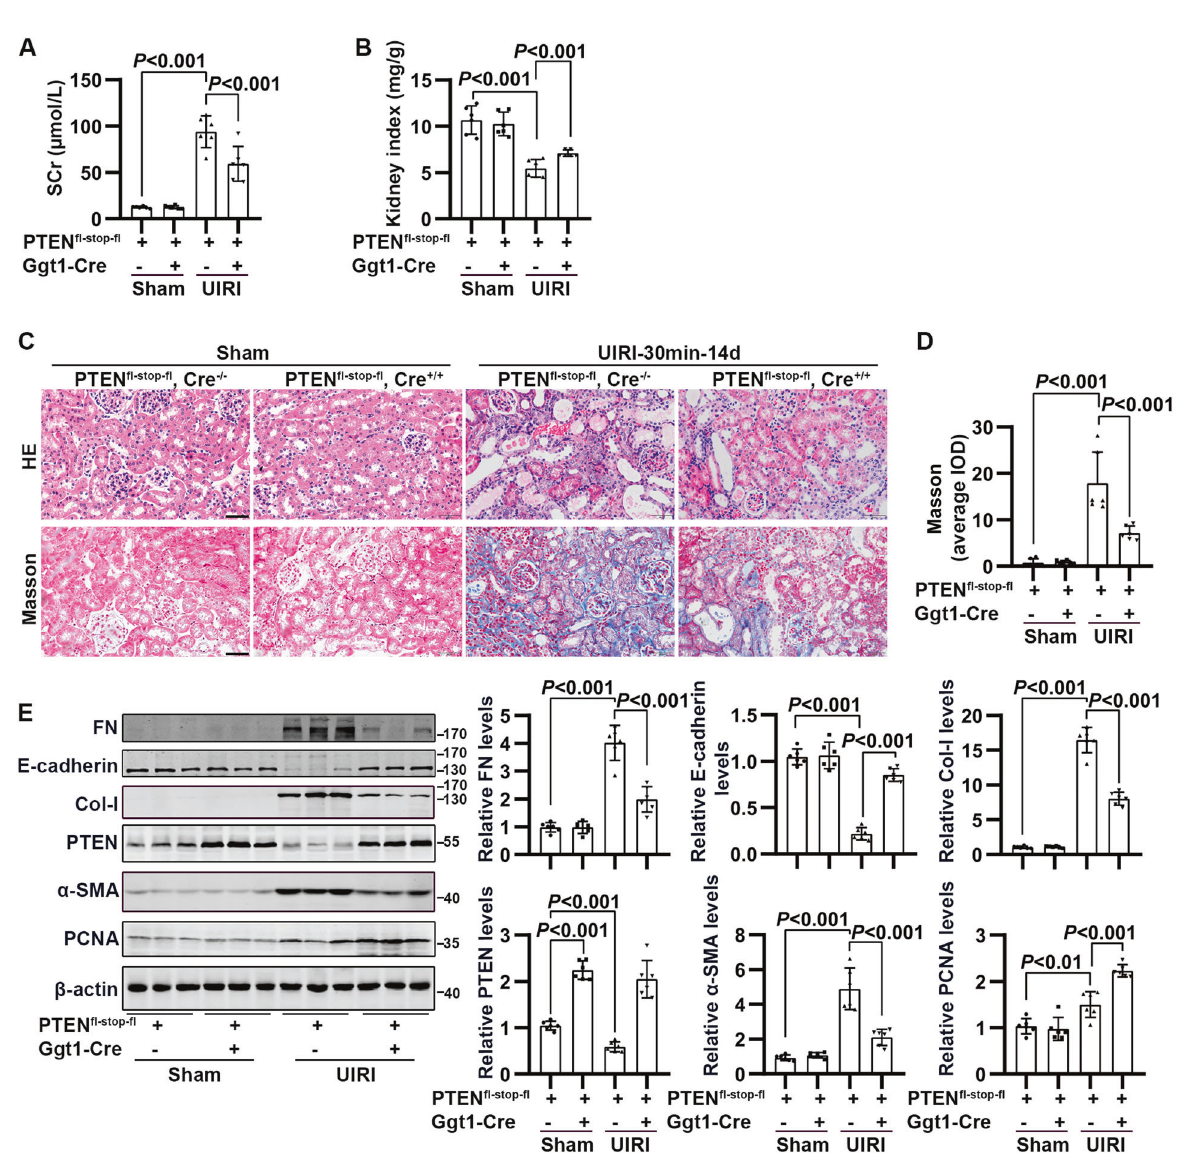
Fig. 3 The effect of renal proximal tubular cell (RPTC)-speci fi c PTEN overexpression on I/R-induced renal regeneration and fi brosis. A Concentration of serum creatinine in PTEN fl -stop- fl , Cre − / − and PTEN fl -stop- fl , Cre + / + mice subjected to unilateral renal artery obstruction for 30 min, followed by 14 days of reperfusion (UIRI). B Quanti fi cation of the ratio of kidney weight to body weight (termed the kidney index) in PTEN fl -stop- fl , Cre − / − and PTEN fl -stop- fl , Cre + / + mice subjected to UIRI. C Representative HE and Masson staining of kidney in PTEN fl -stop- fl , Cre − / − and PTEN fl -stop- fl , Cre + / + mice subjected to UIRI (scale bar, 50 μ m). D Quanti fi cation of Masson-positive areas. E Western blotting analysis showing changes in PTEN and markers of regeneration, redifferentiation, and fi brosis in renal cortex in PTEN fl -stop- fl , Cre − / − and PTEN fl -stop- fl , Cre + / + mice subjected to UIRI ( n = 6 mice in each